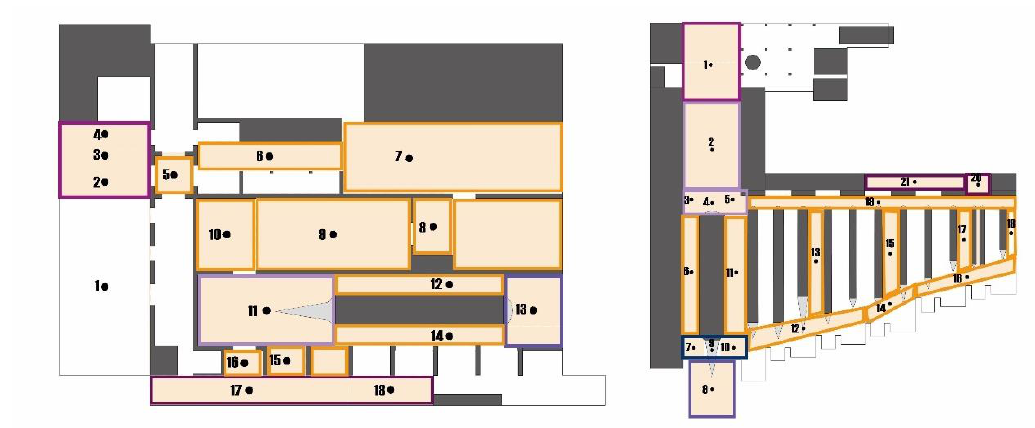
Figure 9 Genova Galata Museo Del Mare the path points of isovist analysis and convex spaces (left), İstanbul Deniz Müzesi the path points of isovist analys and convex spaces (right)